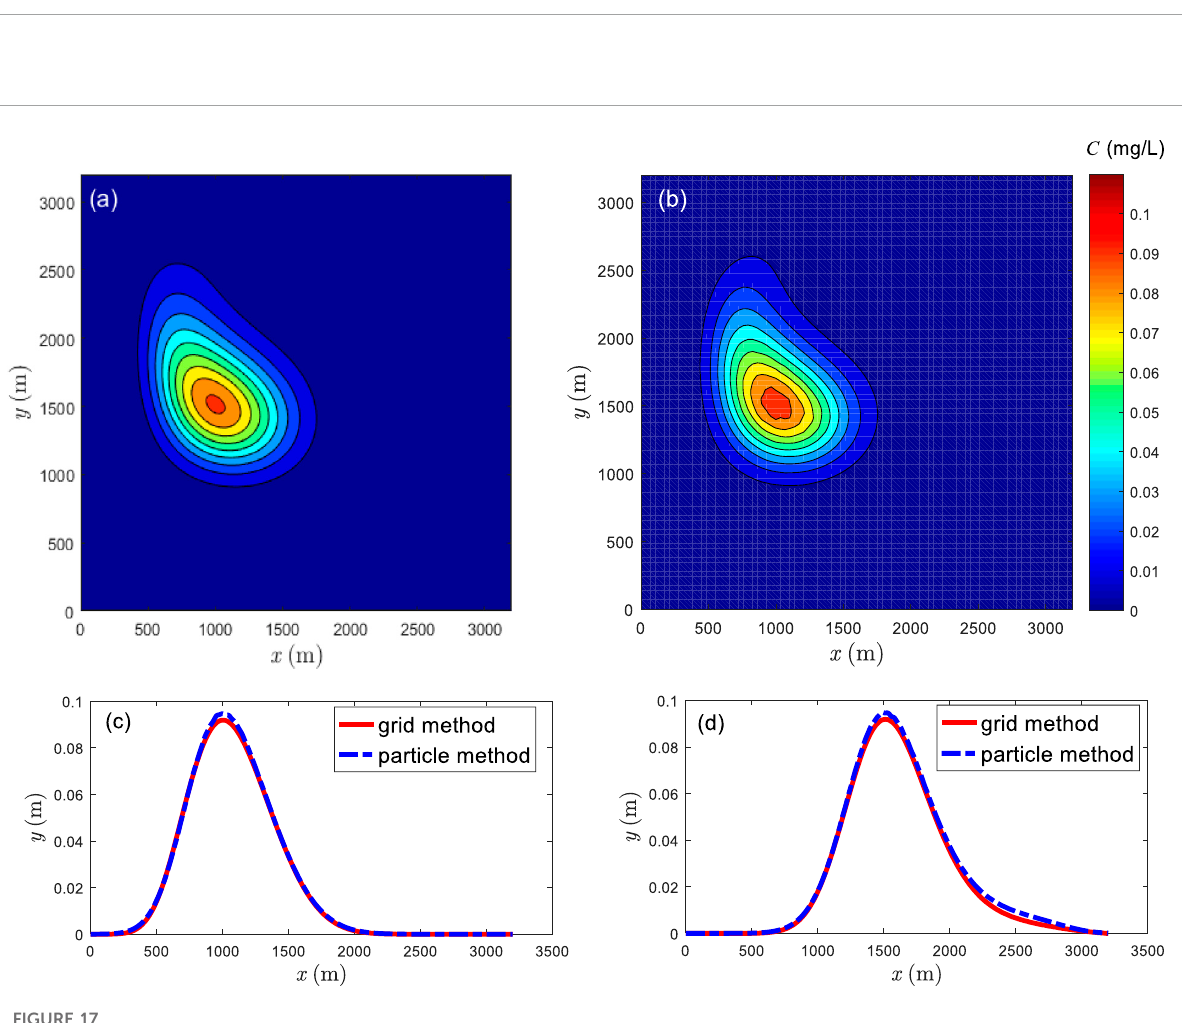
FIGURE 17 Simulations of anisotropic diffusion in fl ow with cavities by (A) grid method and (B) particle method and comparison of concentration pro fi les along (C) y (cid:2) 1500 m and (D) x (cid:2) 1000